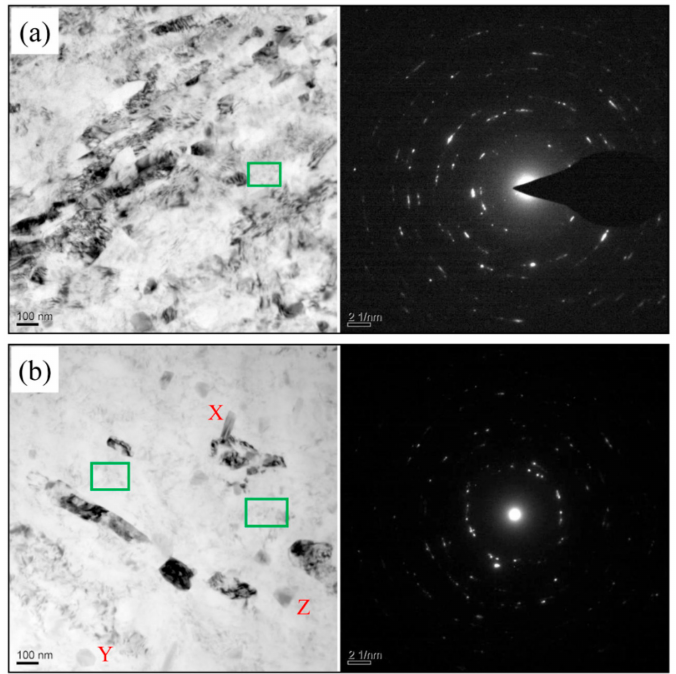
Figure 7. TEM microscopes and corresponding SAED patterns of Al 7075 subjected to ( a ) CT-LSEM and ( b ) RT-LSEM at a machining velocity of Vc = 5.4 m /